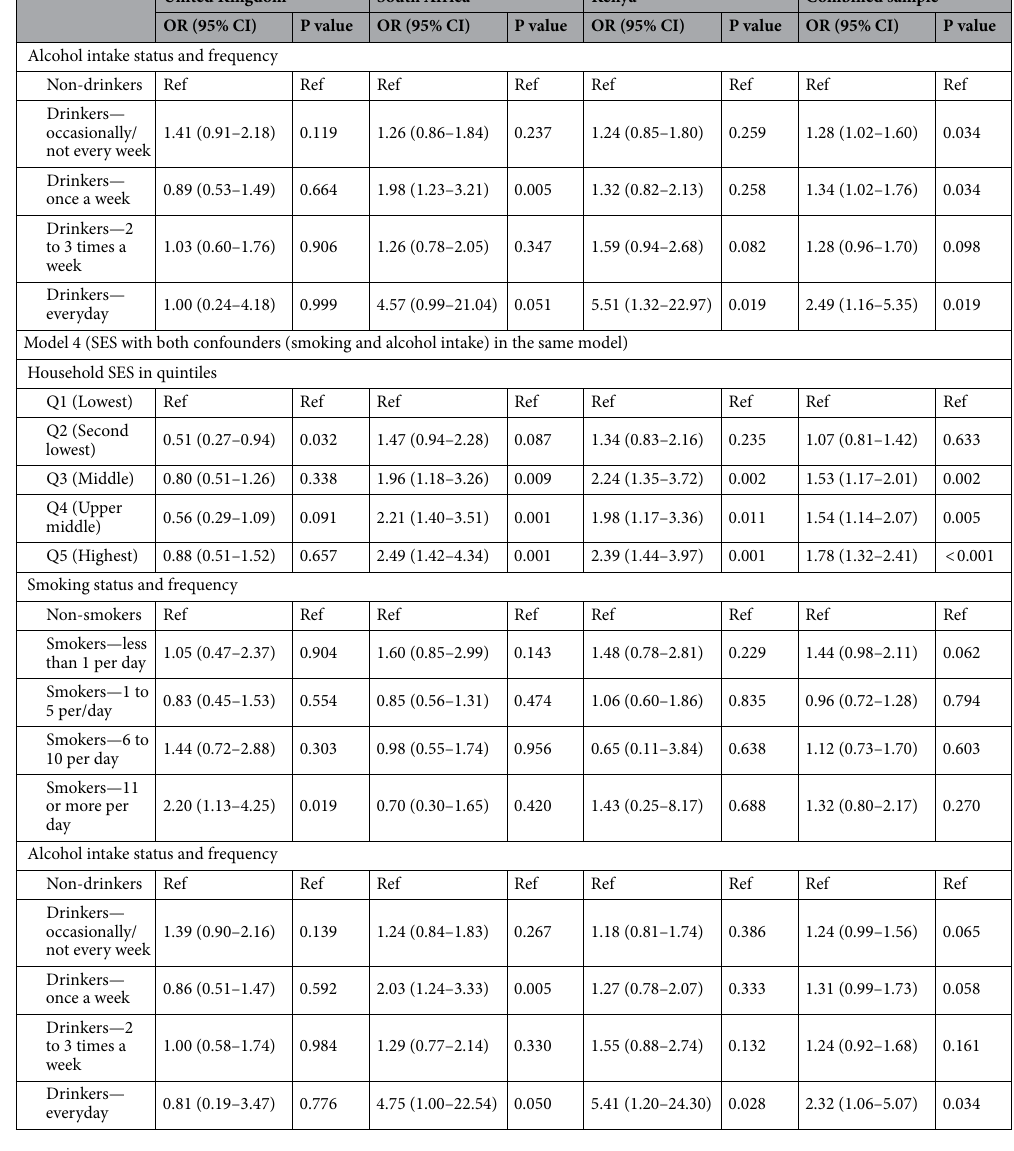
Table 2. Ordered logistic regression analyses for the effect of SES on non-communicable diseases risk, with smoking and alcohol intake as moderators in young adults from United Kingdom, South Africa, and Kenya. Data are presented as odds ratio (OR) and 95% confidence interval (CI). All models were controlled for the potential effect of age, gender, and country (in the combined sample